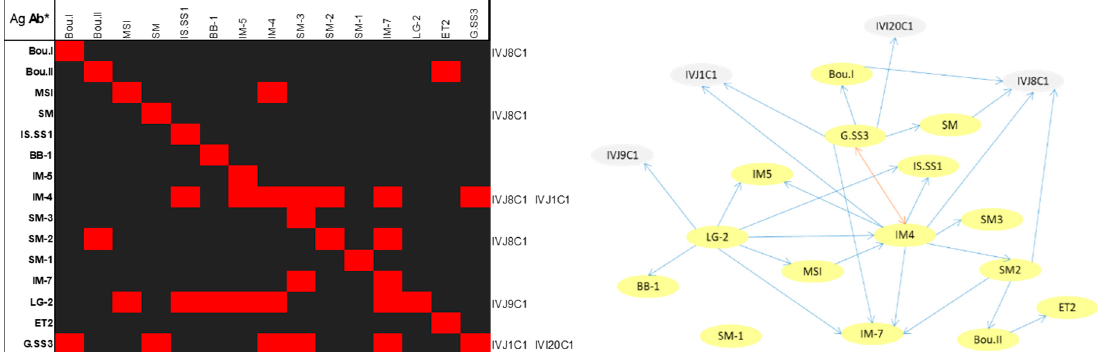
Figure 5. Cross-reactions in the MASE-chip. The heat map on the left shows the positive immunodetections (red squares) of the sandwich immunoassay Ab capture-Ag-Ab trace (*labelled). In the vertical left column, the tested antigens (so they are in rows) are represented. The top line of the table indicates Abs labelled (in columns). The outside column in the right part of the heat map shows the capture Abs printed on the array from previous collection and used in the building of MASE-Chip that cross-react and recognize MASE targets. The image on the right qualitatively shows the cross-reactivity events revealed in the heat map, where yellow circles represent the new Ab from MASE isolates, and the grey ones represent the Ab taken from previous studies. The blue arrows show the recognition of an Ab for the immunogen indicated. The orange arrow represents double direction recognition as happens between G.SS3 and IM-4 antibodies. The self-loops were not drawn to improve the clarity of the image. (The length of arrows is not informative of quantification).